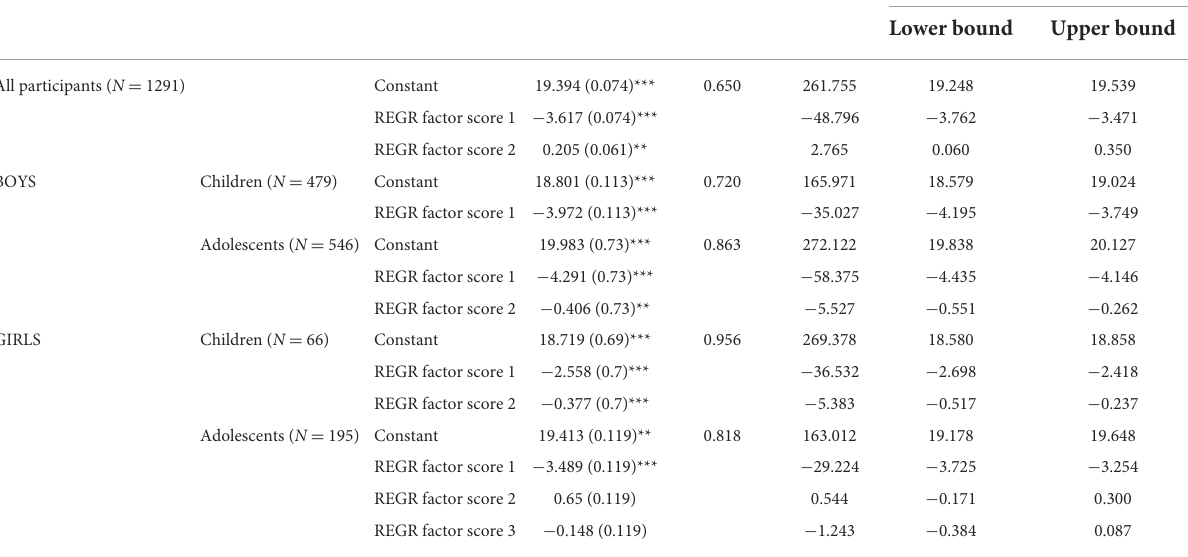
TABLE 7 Multiple linear regression analysis for associations between BMI and physical fitness of Saudi students aged 10–17.